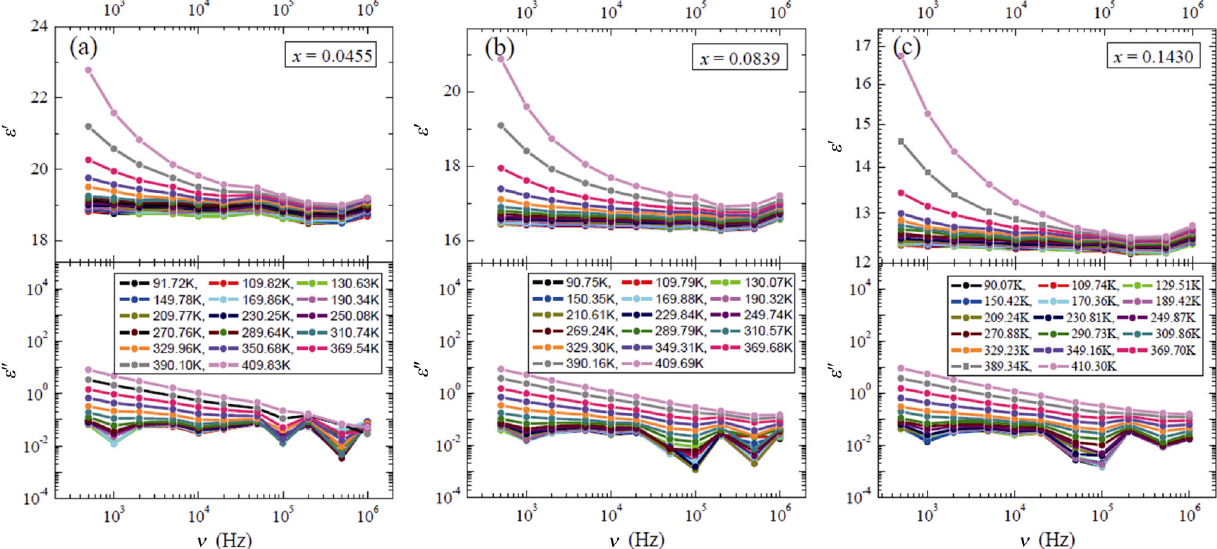
Fig. 10 Representative ε  ( v ) and ε  ( v ) spectra for selected, the same temperatures and for Pb 1–3 x (cid:0) x Gd 2 x (MoO 4 ) 1–3 x (WO 4 ) 3 x samples when (a) x = 0.0455, (b) x = 0.0839, and (c) x =